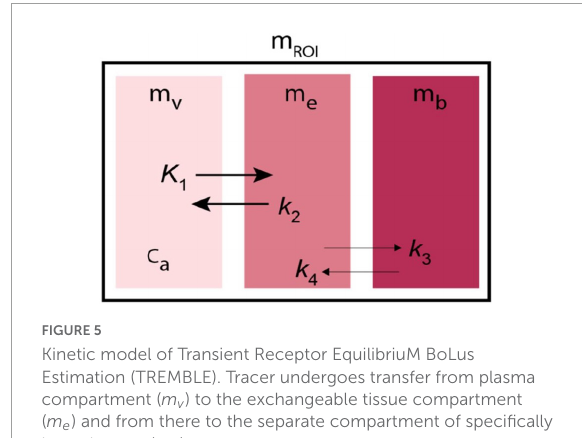
FIGURE5 Kinetic model of Transient Receptor EquilibriuM BoLus Estimation (TREMBLE). Tracer undergoes transfer from plasma compartment ( m v ) to the exchangeable tissue compartment ( m e ) and from there to the separate compartment of specifically bound tracer ( m b